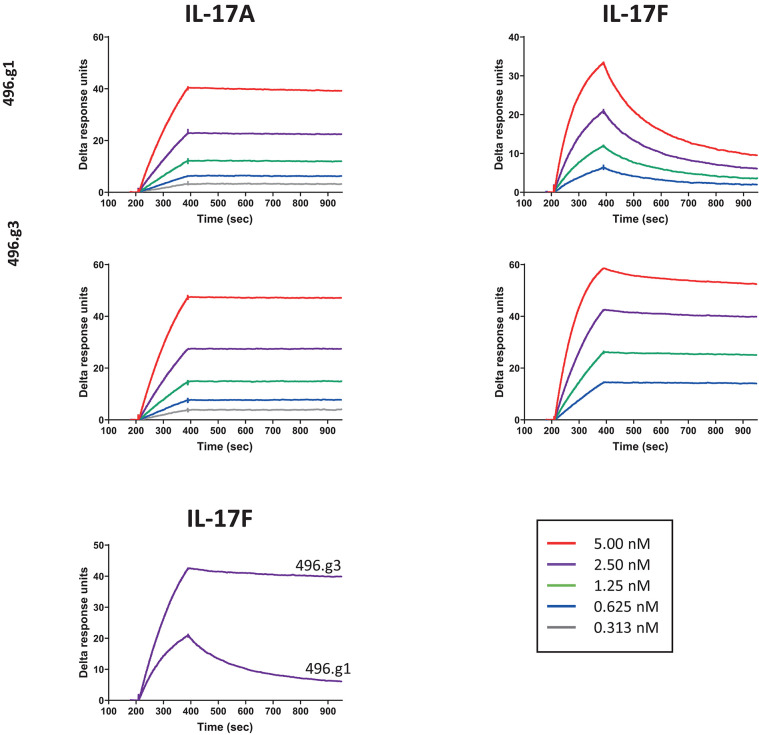
Affinity of 496.g3 to IL-17A and IL-17F. Anti-human F(ab′)2 was immobilized onto a CM5 sensor chip surface followed by the capture of either 496.g1 or 496.g3 Fabs. The association phase showed an increase in response over time following the injection of varying concentrations of IL-17A (5–0.313 nM) and IL-17F (5–0.625 nM) and this was followed by the dissociation phase when buffer replaced the IL-17A and IL-17F.